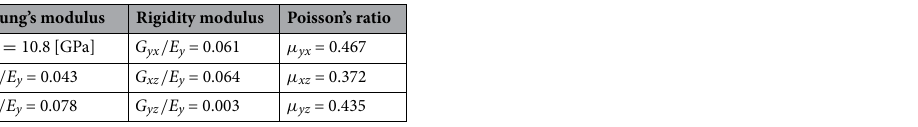
Table 1. Values of the orthotropic properties of the simulated material, density ρ = 450 kg/m 3 .